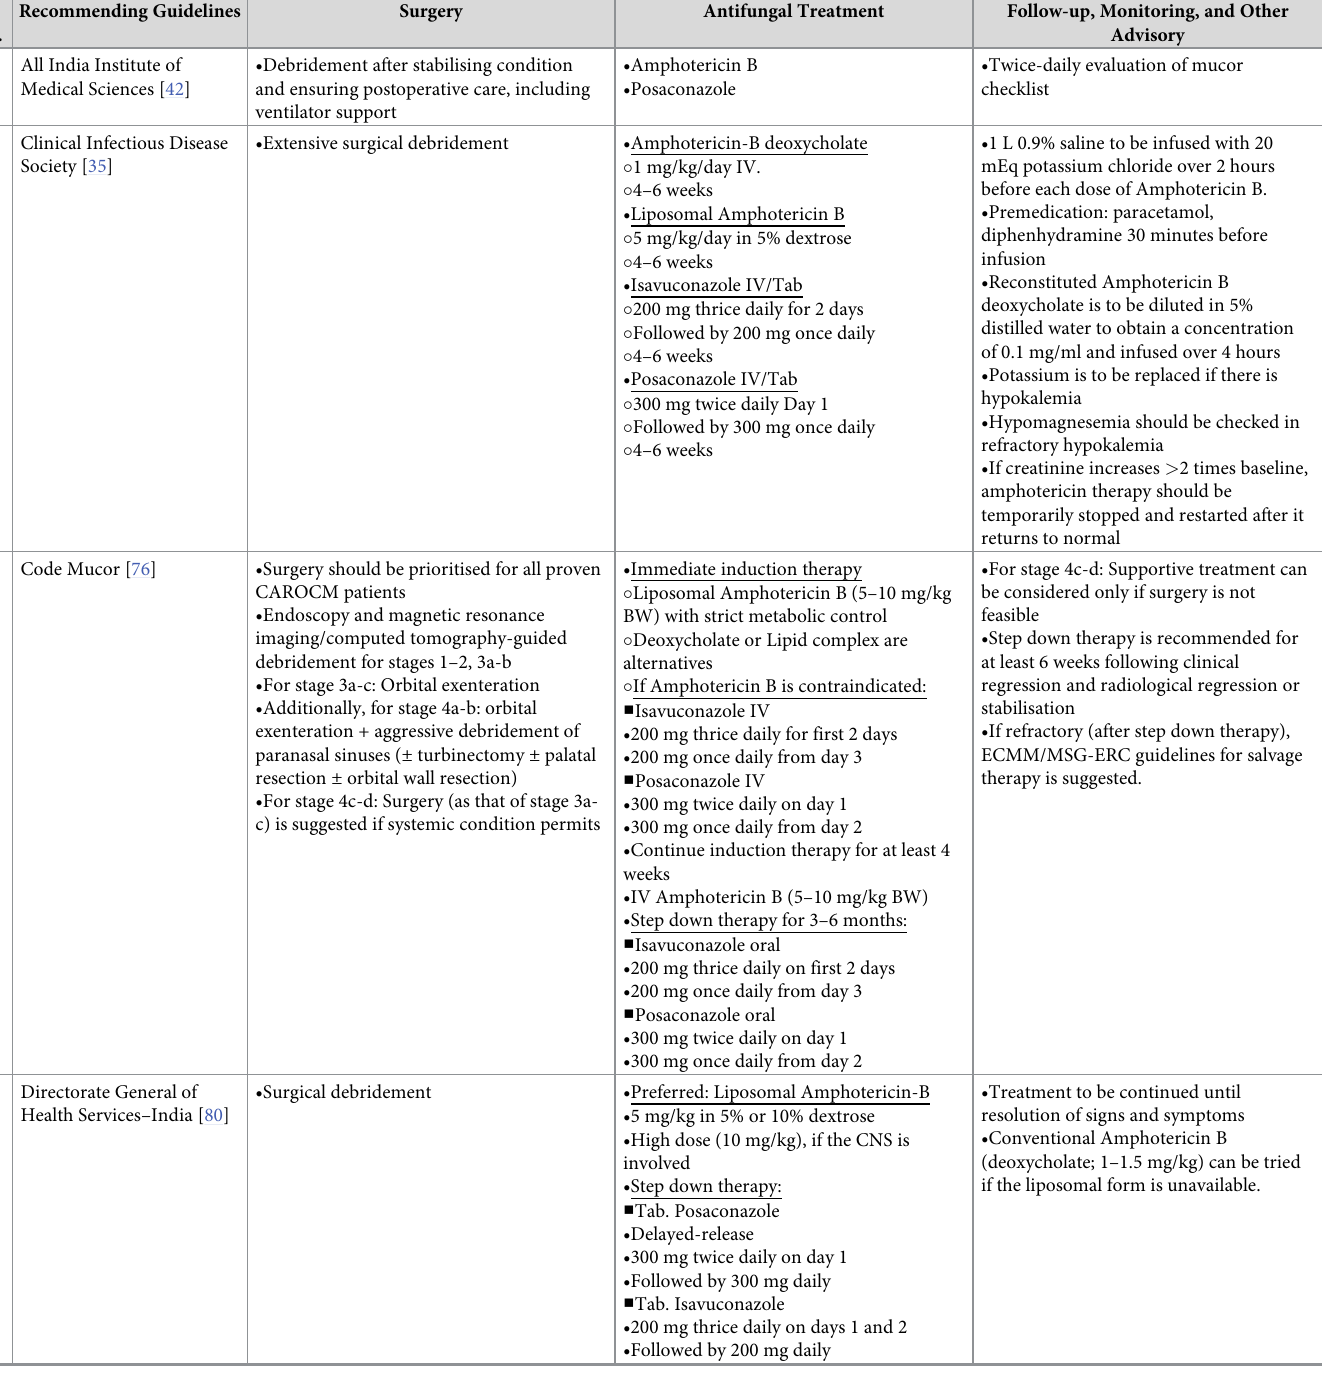
Table 1. Recommendations on treating CAM in